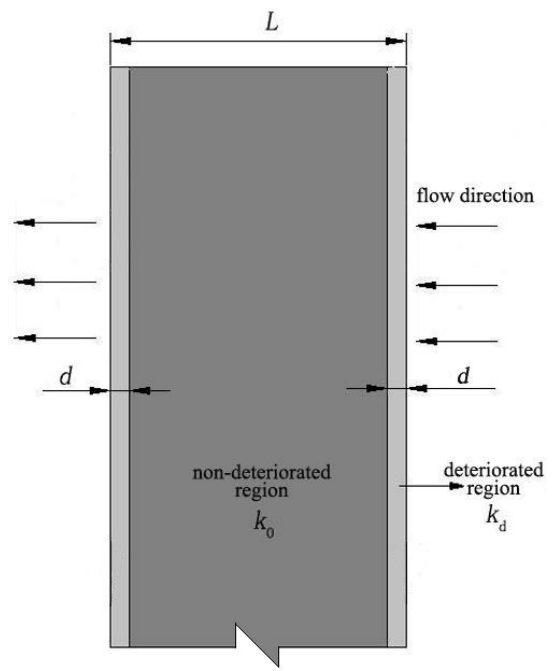
Figure 16. Deterioration of the diaphragm wall.